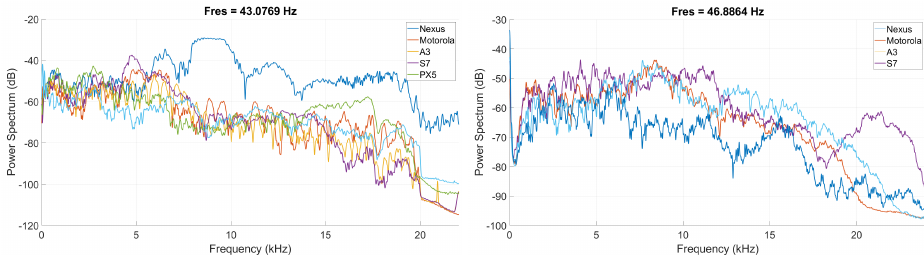
Figure 3. The power spectrum of audio signal recorded ( left ) and played ( right ) by the devices used in our